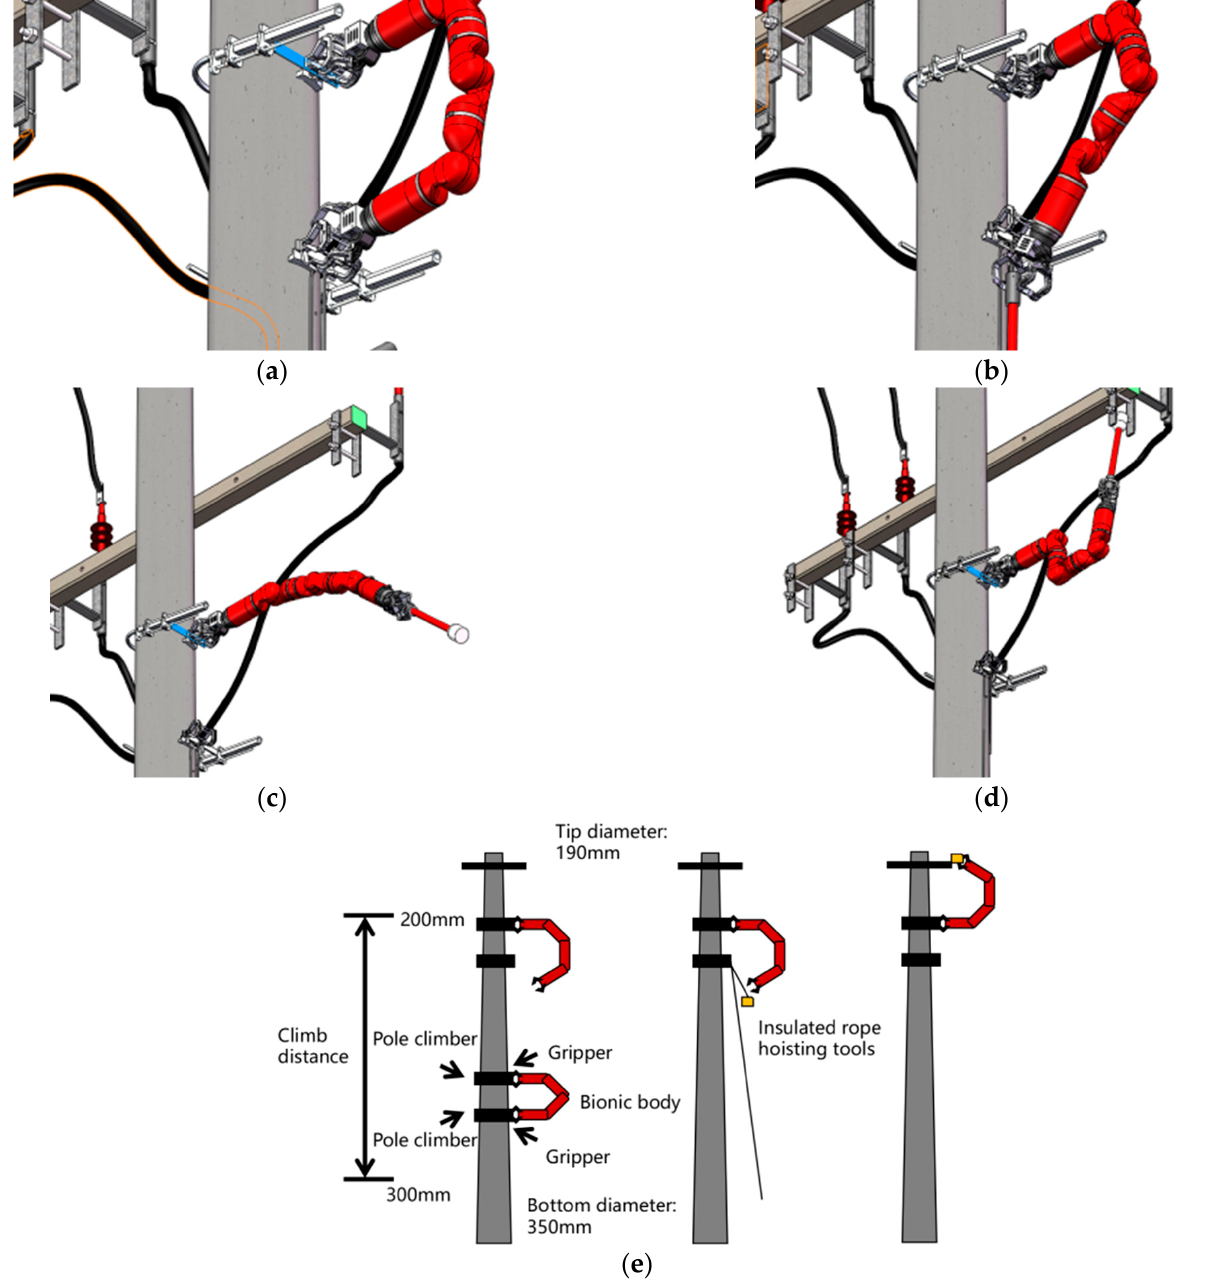
Figure 20. Operation process. ( a ) Initial state, ( b ) motion 1, ( c ) motion 2, ( d ) motion 3, ( e ) front elevation of operation